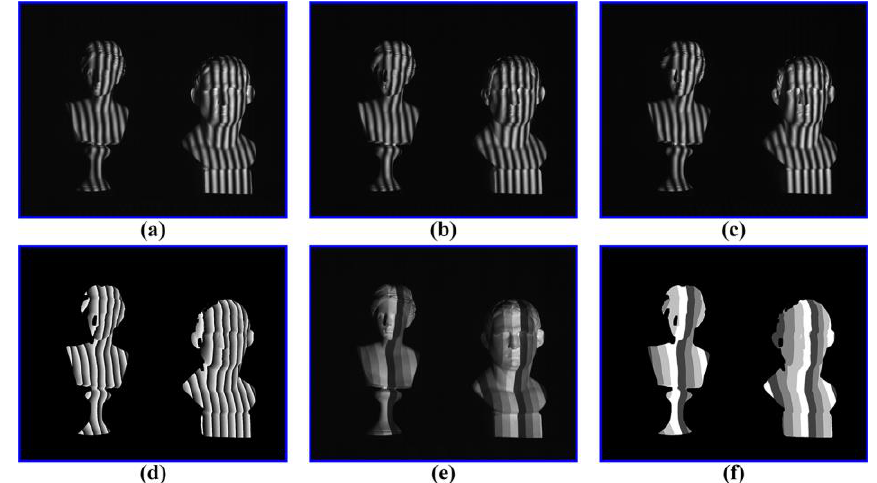
Figure 10. Images of the measured objects. ( a – c ) Phase-shift patterns; ( d ) wrapped phase map; ( e ) coded pattern; ( f ) code-word map.